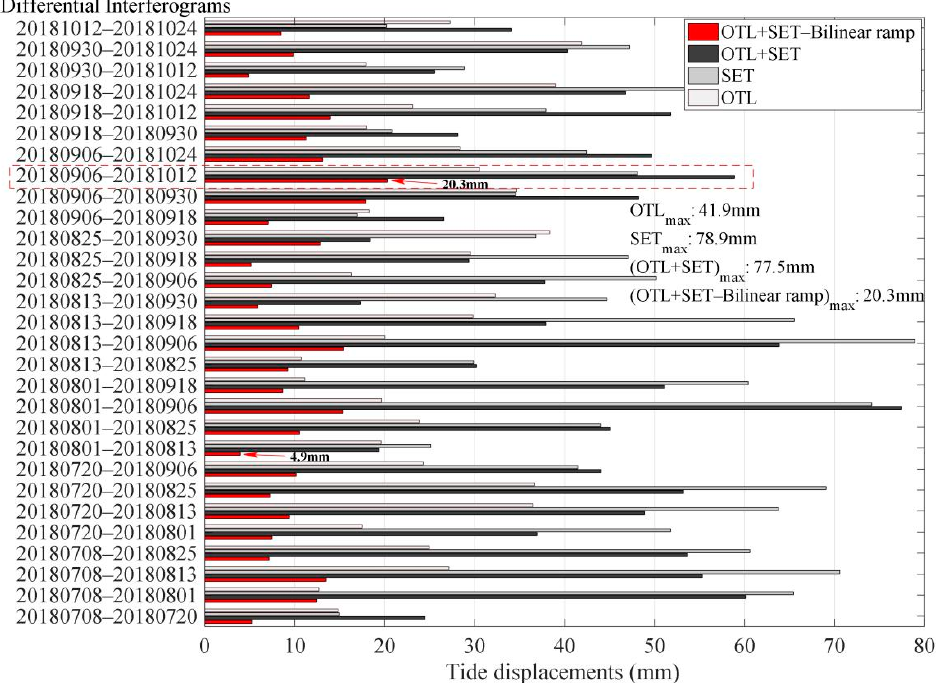
Figure 6. The SET and OTL displacements in 29 long-strip differential interferograms and the error analysis of residual tidal displacement produced by bilinear fitting ramp, and the interferogram with largest residual tidal displacement (red box).